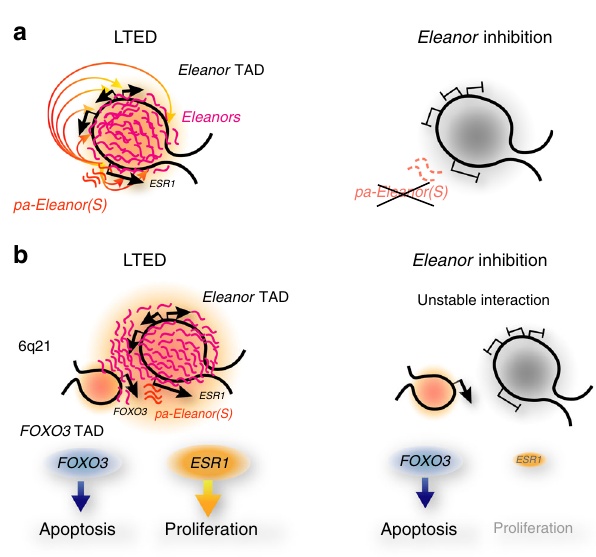
Fig. 7 Proposed model of Eleanor functions in long-term estrogen deprivation (LTED) cells. Eleanors play roles in activating genes within the Eleanor topologically associating domain (TAD) ( a ) and in mediating the long-range chromatin interaction ( b ). a In LTED cells, pa-Eleanor(S) activates the transcription of Eleanors and RNA cloud formation, thus activating the genes in the Eleanor TAD, including ESR1 (left). Eleanor inhibition represses the Eleanor TAD (right). b In LTED cells, the gene for proliferation ( ESR1 ) and the gene for apoptosis ( FOXO3) are in close proximity, as both are active in the A compartment. Upon inhibition of Eleanors by resveratrol or pa-Eleanor(S) knockdown, the long-range chromatin interaction decreased and the ESR1 gene was repressed, but the FOXO3 gene activity was maintained at a high level. These suggest a mechanism underlying the apoptosis-prone nature of LTED